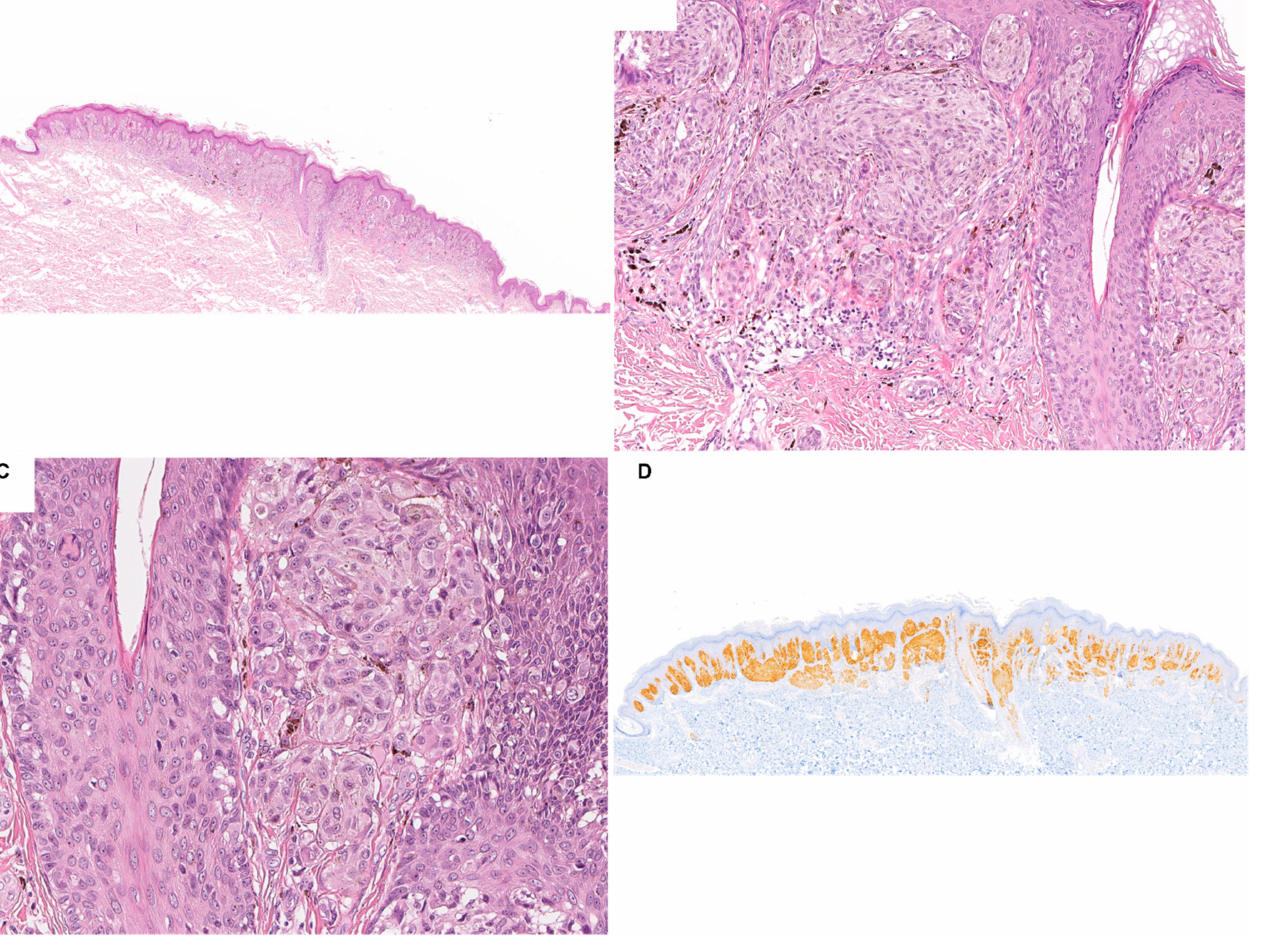
Figure 4. Photomicrographs of an atypical Spitz tumor harboring NTRK1 fusion showing a slightly raised, compound, and symmetric melanocytic proliferation with filigree-like rete ridges, flat-base silhouette, and lobulated nests of epithelioid and spindle melanocytes with moderate nuclear pleo- morphism ( A – C ) H&E staining; original magnification 12.5 × , 100 × , and 200 × , respectively). Pan- TRK (clone EPR17341) immunohistochemistry showing a diffuse cytoplasmic staining (( D ) original magnification 12.5 ×